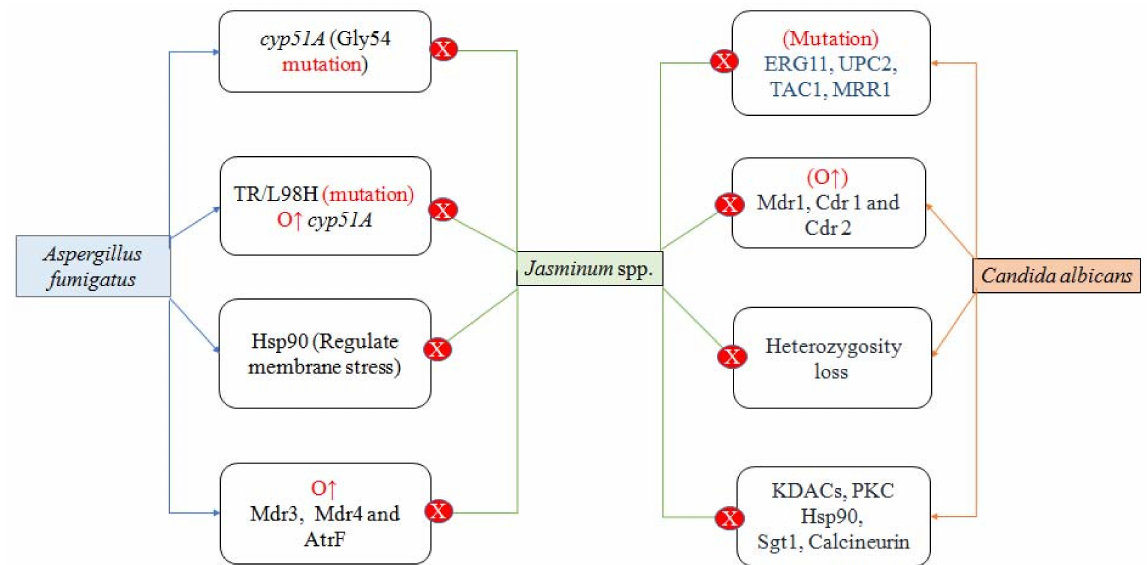
Figure 3. Markers of antifungal resistance in Aspergillus fumigatus and Candida albicans and protective role of Jasminum plants against the same. Overexpression (O ↑ ); Lanosterol 14- α demethylase (ERG11); Transcription factor (UPC2, MRR1), Hsp90 (Heat shock protein-90), Cytochrome P450 14 α -sterol demethylases ( Cyp51 ); Multidrug resistant (MDR); Complementarity- determining regions (CDRs), Lysine deacetylases ( KDAC ); Protein kinase C (PKC), ATP Binding Cassette transporter gene (AtrF); Transcriptional activator of CDR genes